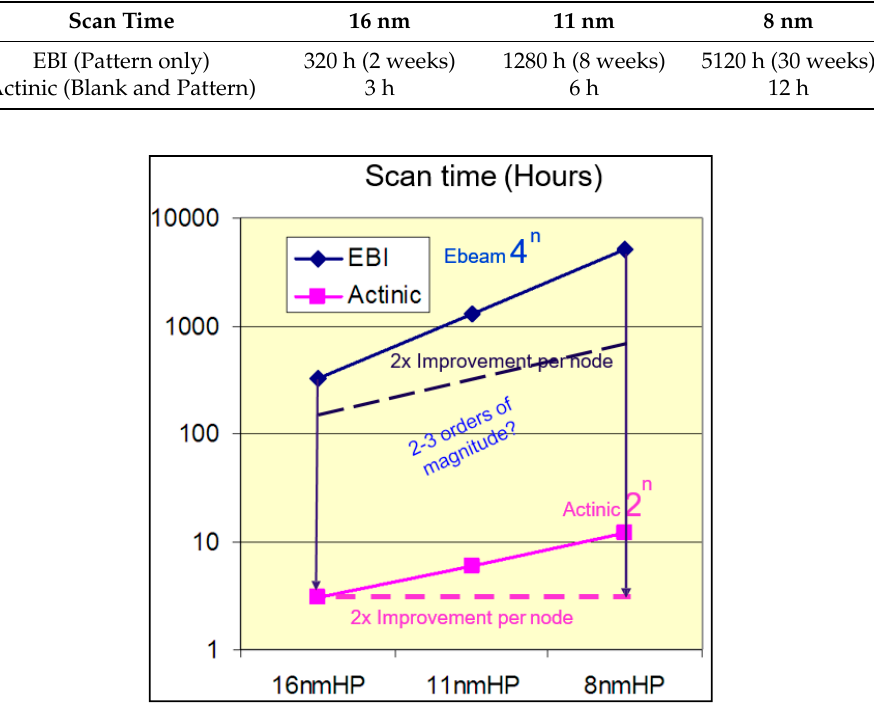
Figure 25. Scan time comparison.